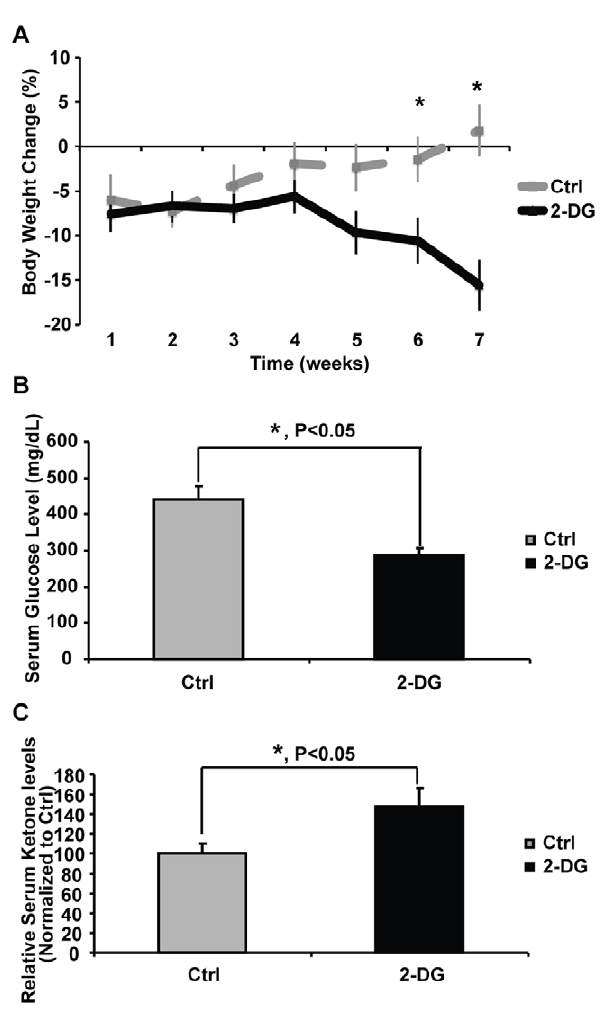
Figure 2. Induction of ketogenesis by 2-DG invivo . 3xTgAD female mice at 6 months of age were randomly assigned to either Ctrl (AIN93G) or 2-DG (AIN93G + 0.04% 2-DG) group. Body weight was monitored once per week. Percent of Change is defined as (BW 0n -BW 00 )/ BW 00 *100% ( 00 , week 0 prior to the beginning of the treatment; 0n , weeks of duration on designated diet). Animals were sacrificed upon completion of 7 weeks of treatment. Serum samples were collected for glucose and ketone body level measurement. A, 2-DG induced body weight loss (*, P , 0.05 compared to Ctrl, data points represent mean value 6 SEM). B, 2-DG induced significant decline in serum glucose level (*, P , 0.05 compared to Ctrl, bars represent mean value 6 SEM). C, 2-DG induced significant increase in serum ketone body level (*, P , 0.05 compared to Ctrl, bars represent mean b -hydroxybutyrate level 6 SEM).